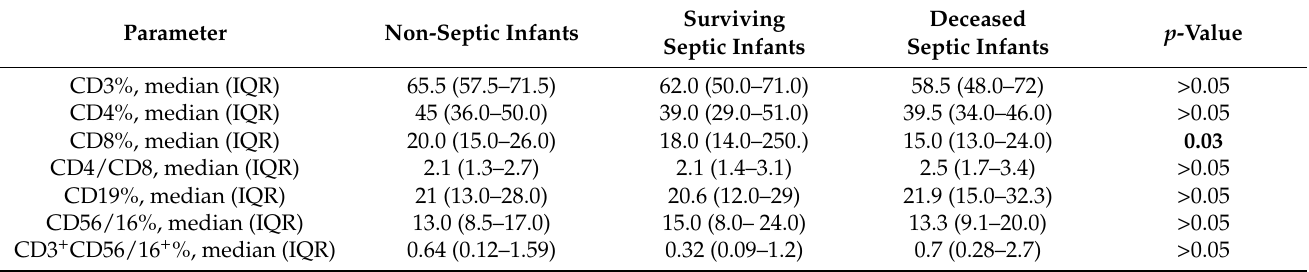
Table 4. Immune status in newborns hospitalized with sepsis.